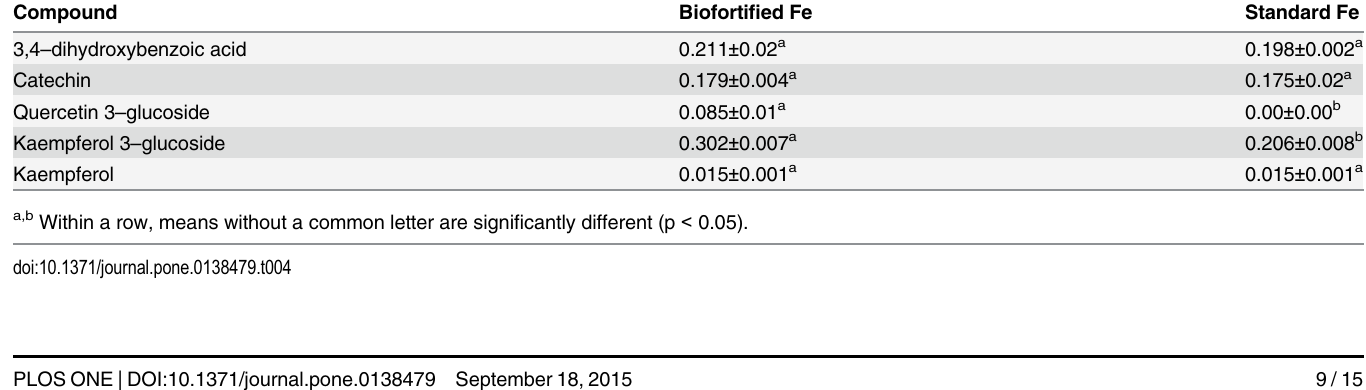
Significant differences in phytate concentration were measured between biofortified and stan- dard bean diets (n = 5, p < 0.05, Table 1). In addition, phytate:Fe ratios differed significantly between diets (15.43 ± 0.85 and 10.95 ± 0.65 for the standard bean and biofortified red mottled an bean based diets, respectively, n = 5, p < 0.05, Table 1). Table 4. Concentrations ( μ mol/g) of prevalent polyphenols observed in the cream seeded Carioca Beans seed coats. Compound Bioforti fi ed Fe